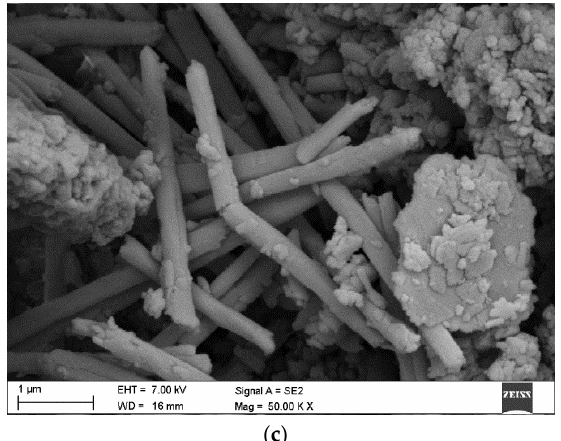
Figure 3. SEM images Dunino halloysite samples with ( a ) halloysiteite nanoplates (HNP) with an occasional intrusion of nanotubes (HNT); ( b , c ) mixed halloysiteite nanotubes (HNT) and halloysiteite nanoplates.